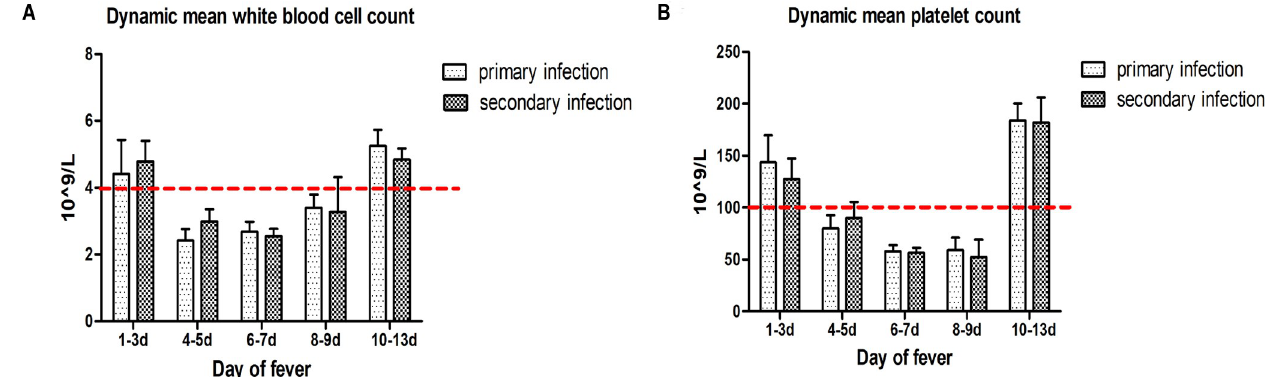
Fig 6. Mean values of (A) white blood cell counts and (B) platelet counts in DENV positive patients with primary or secondary DENV infection at different onset days after fever.